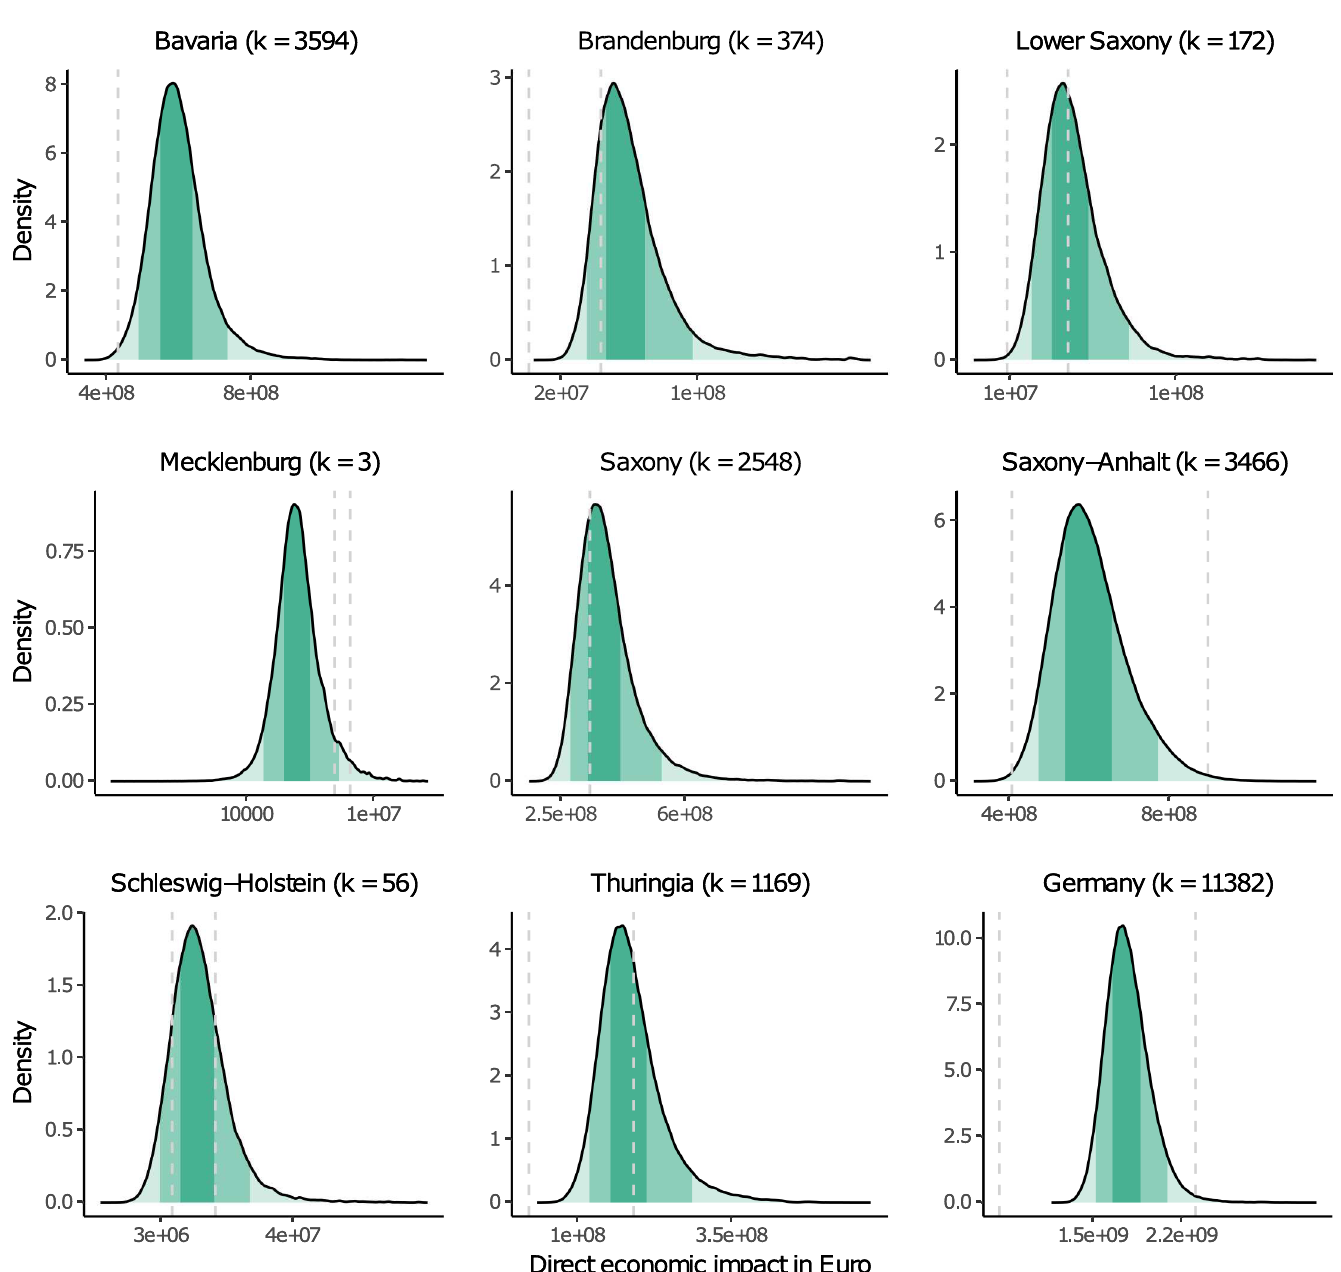
Fig 2. Distributions of estimated direct economic impact for k affected companies in the respective federal states. The grey dashed lines indicate the range of the assumed direct economic impact from reports of the respective federal states [44]. The different greens indicate the 50% and 90% intervals.